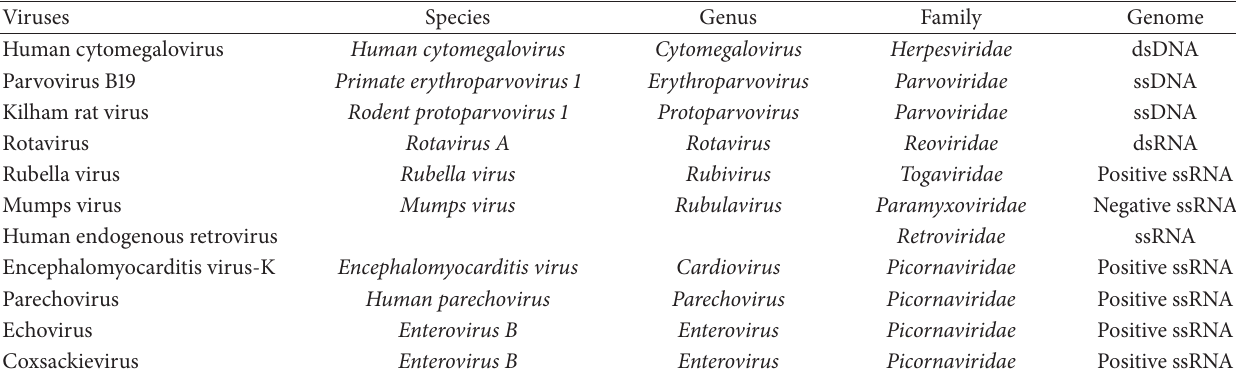
Table 4: An overview of the viruses associated with T1D and their classification.